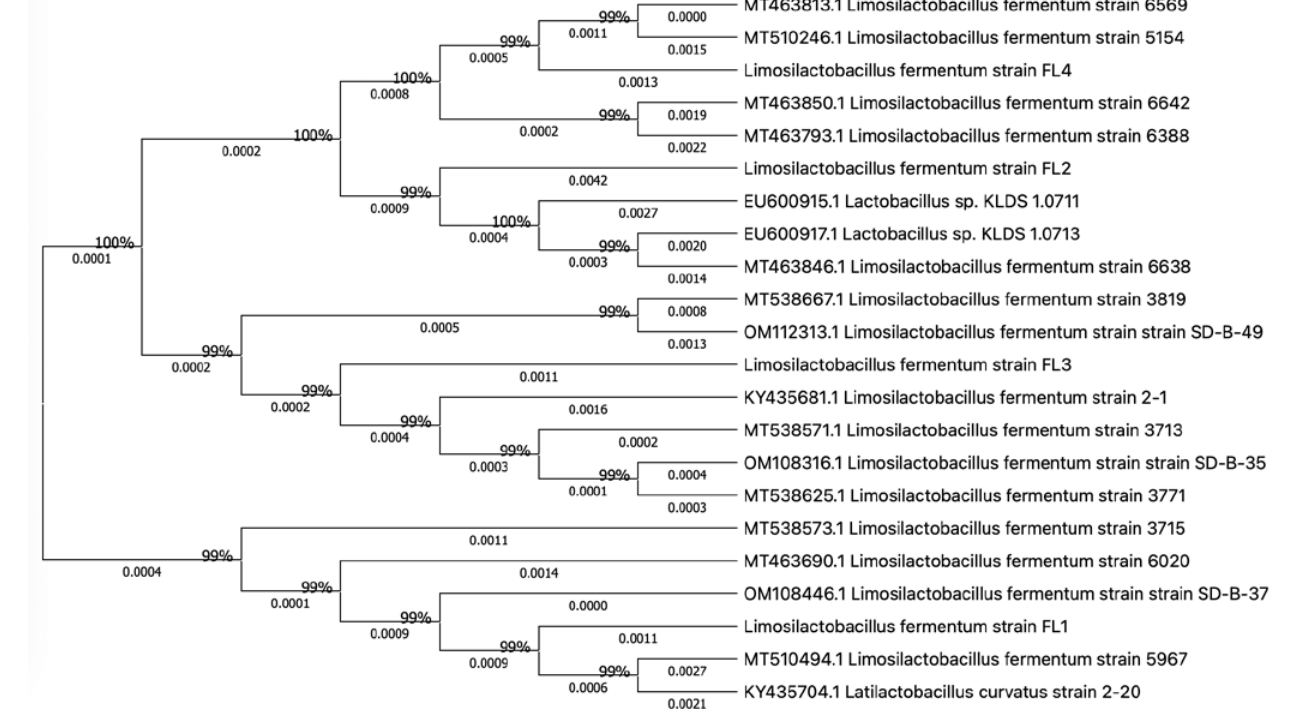
Figure 1. Phylogenetic tree of strains based on 16R rRNA sequence.